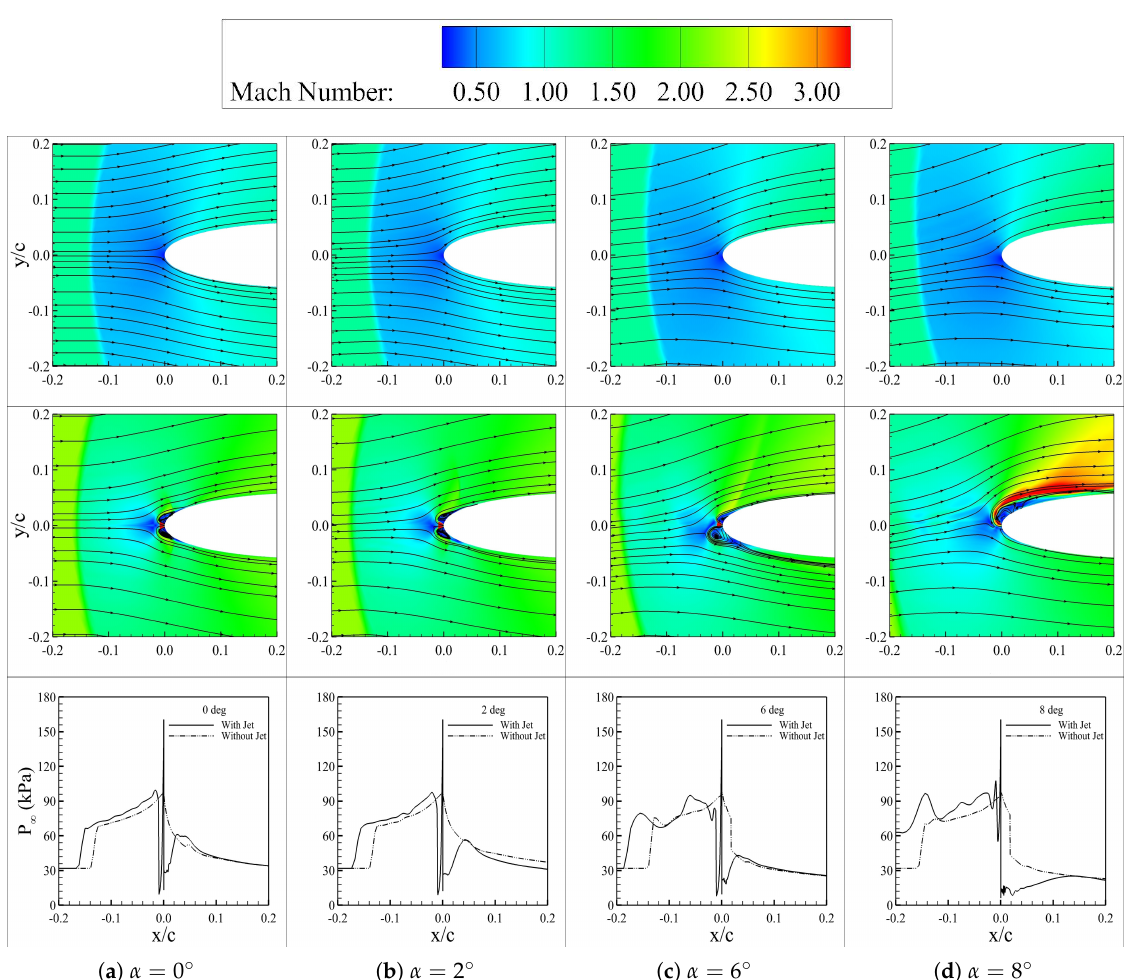
Figure 12. Pressure distribution of free stream flow with increasing angles of attack ( α = 0 ◦ to 8 ◦ ) at constant PR = 3.0 and M ∞ =